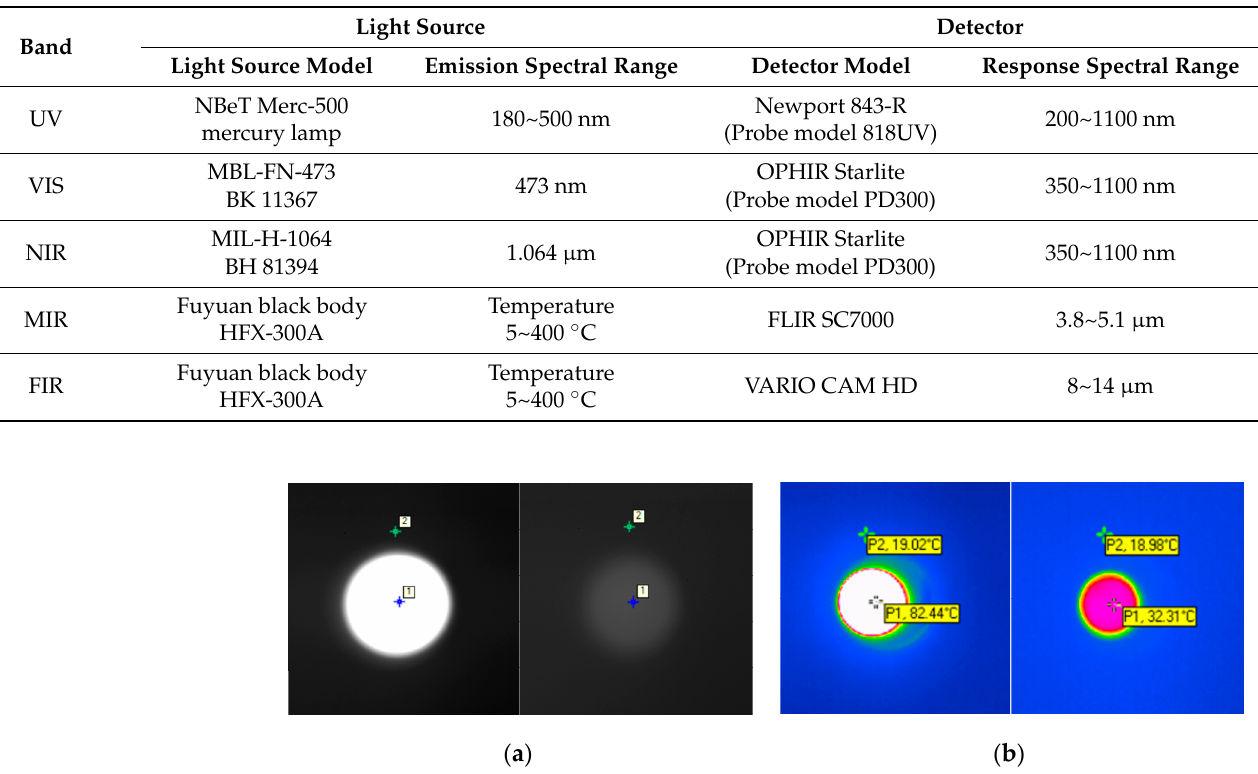
Table 1. Light sources and detectors in the broadband extinction performance test system.